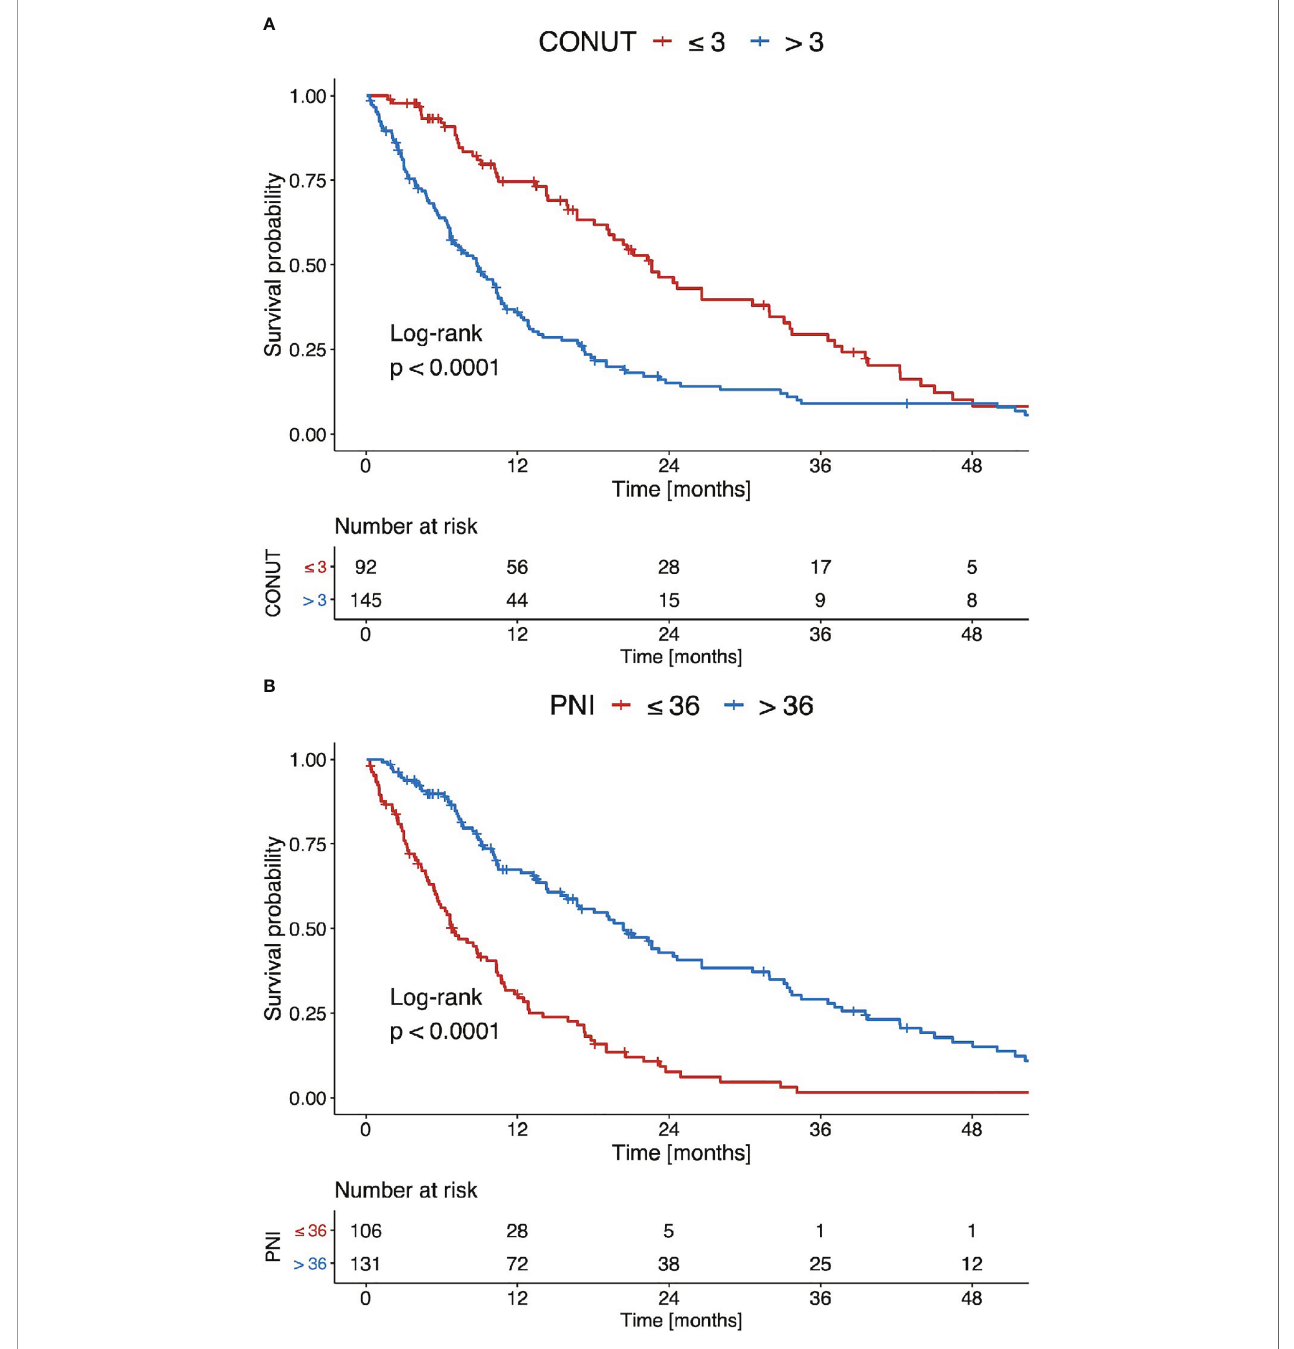
FIGURE 3 | Kaplan Meier curves of overall survival strati fi ed according to (A) the CONUT score and (B) the PNI for the entire patient